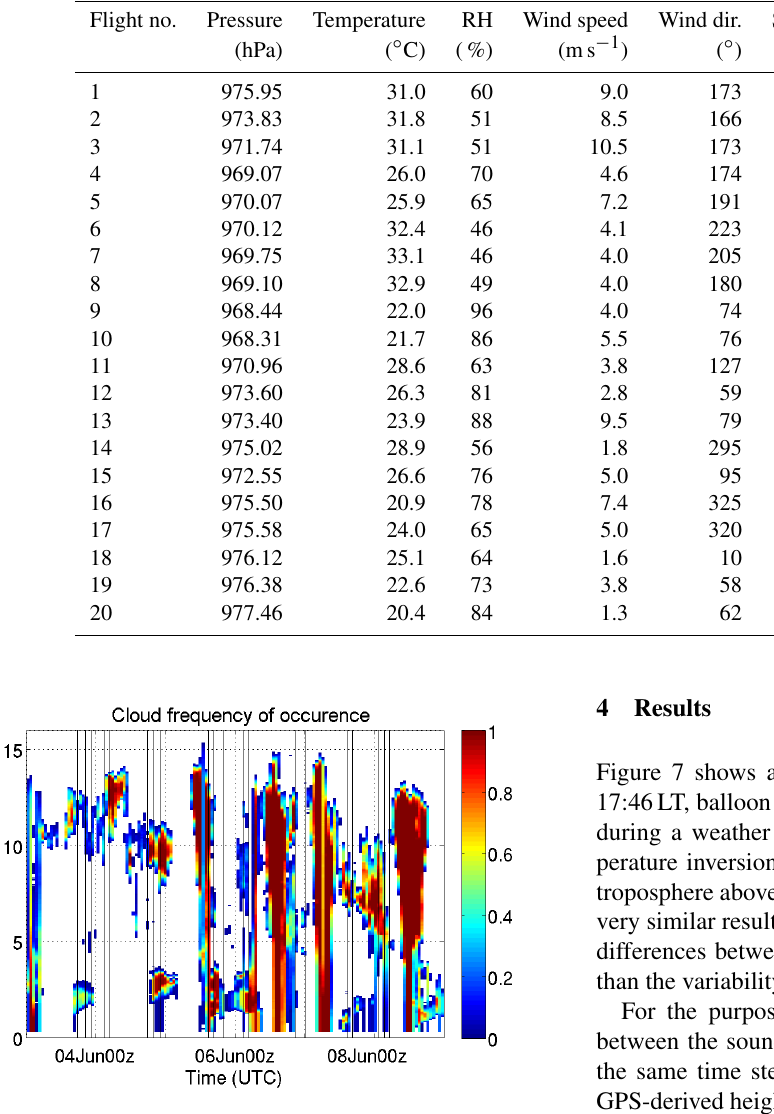
Figure 6. Cloud frequency of occurrence as a function of time and height (above mean sea level) based on the Active Remote Sensing of CLouds (ARSCL) product. Occurrence statistics are determined over a 1h time window and a 30m height window. Vertical black lines represent the times of radiosonde